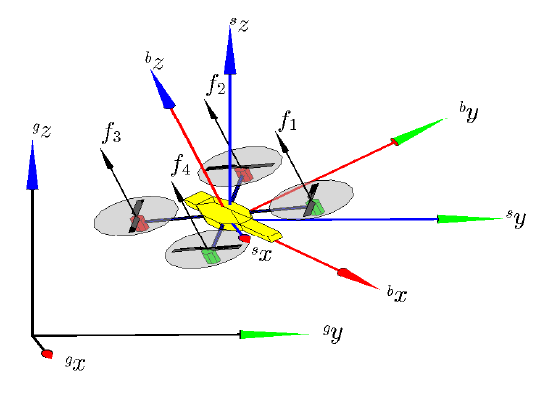
Figure 1. Six-DOF CAD model of a quadrotor, including the reference frames and abstract control inputs (forces f i , i = 1, · · · ,4) associated with it. The inertial, the spatial, and the body reference frames are referred to as (cid:104) e (cid:105) , (cid:104) s (cid:105) , and (cid:104) b (cid:105) , respectively.